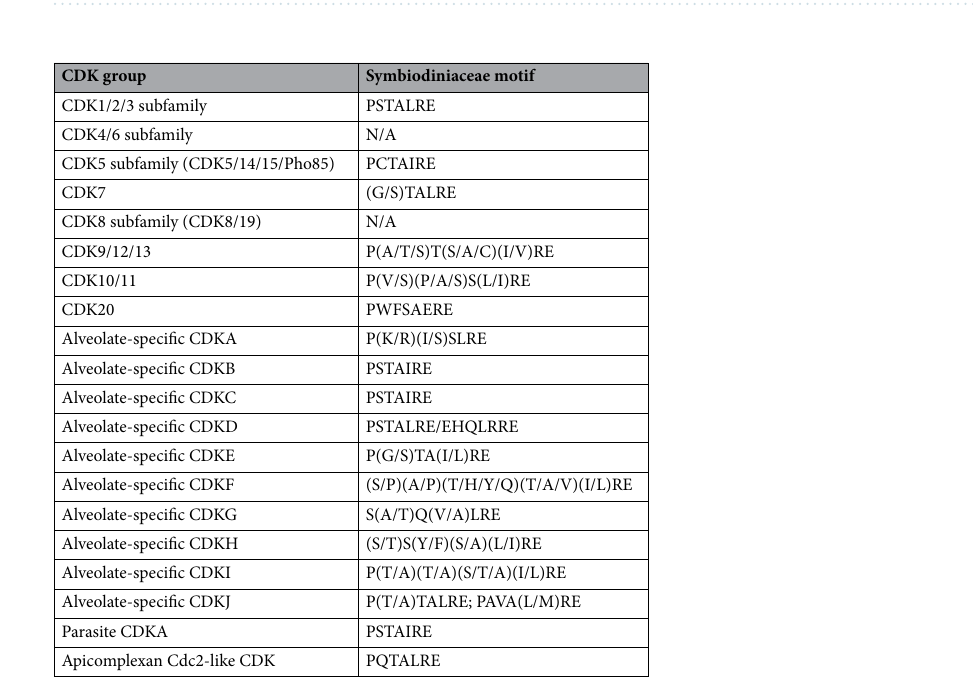
Table 2. Conserved motifs found in the Symbiodiniaceae CDK